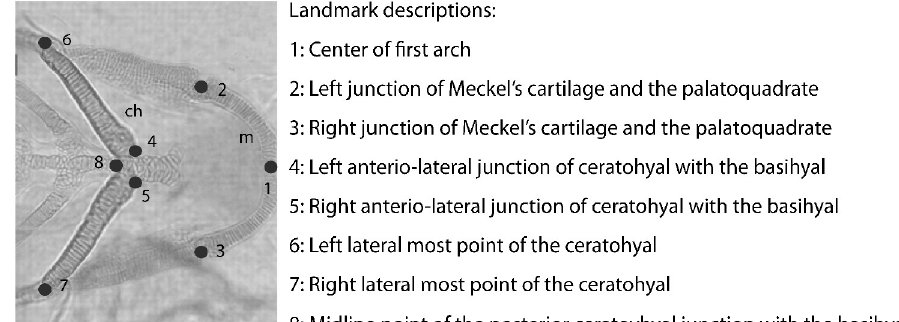
Figure 1 : Landmark key.